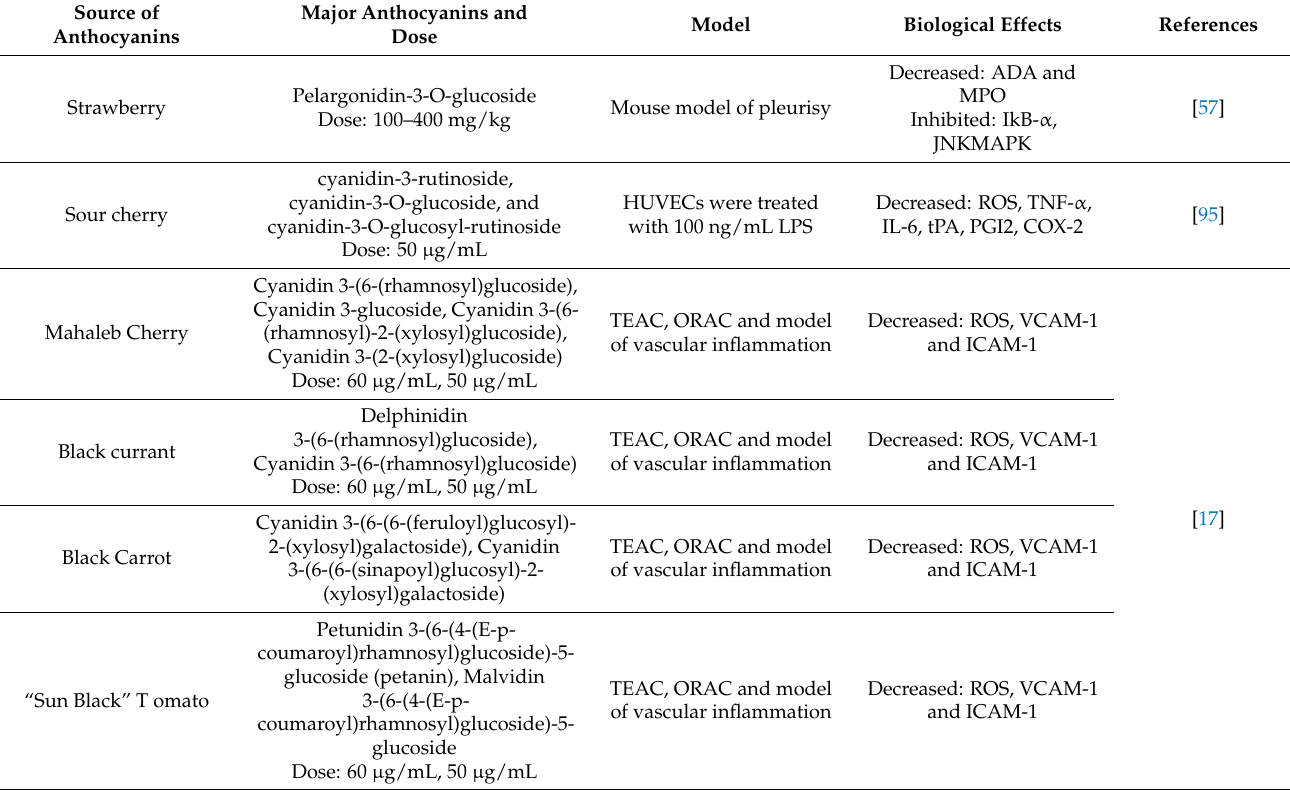
Table 3. The Mechanisms of Action of